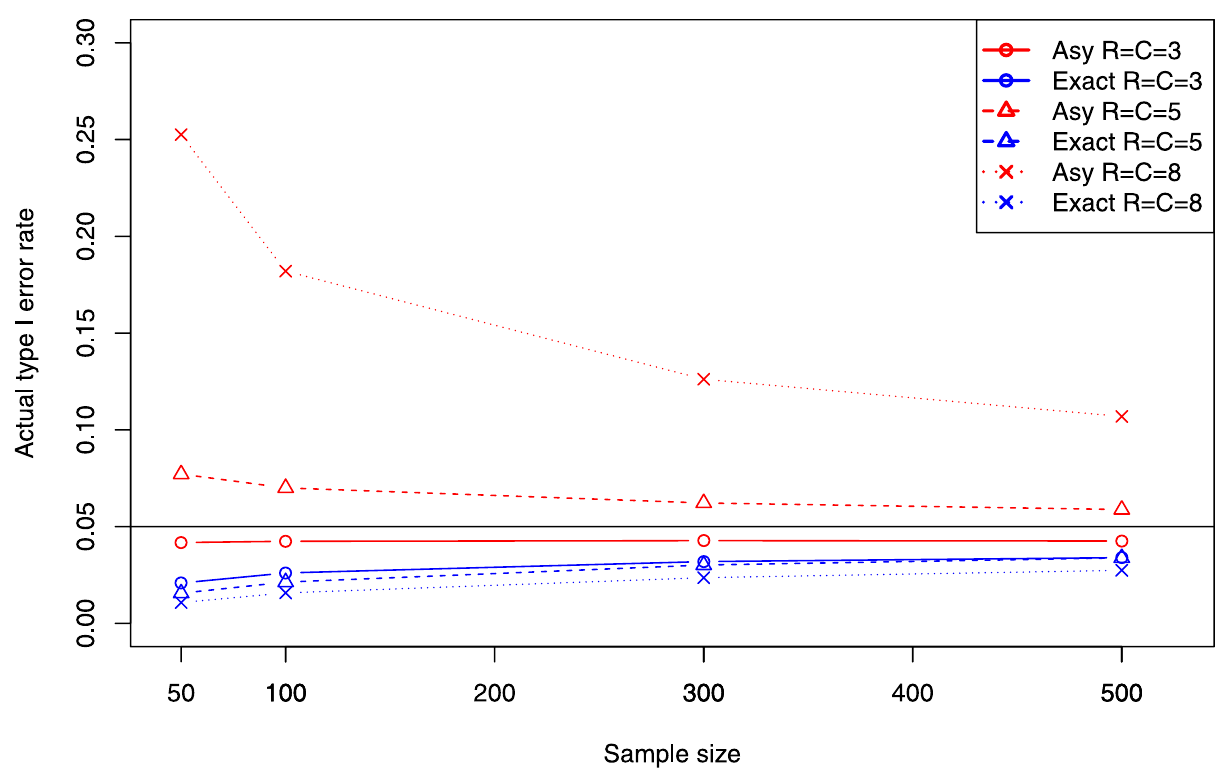
Fig 1. Actual family-wise error rates of the proposed exact approach and the existing asymptotic approach based on the adjusted residual at the nominal level of 0.05.